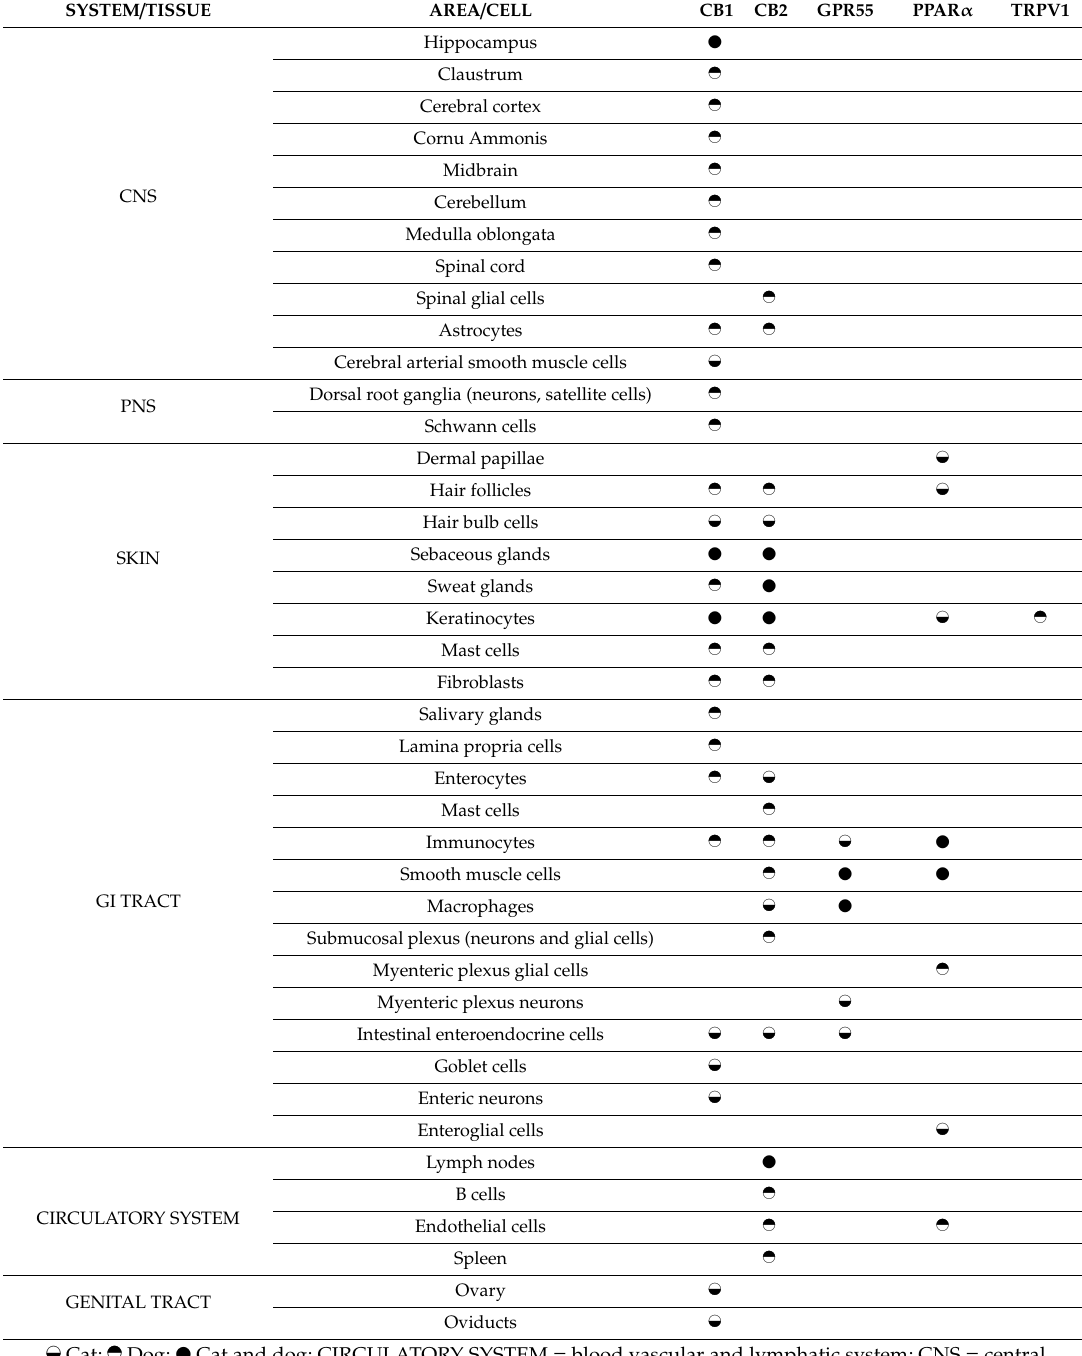
Table 2. A glance over cannabinoid receptor distribution in dogs and cats [95–109]. SYSTEM /